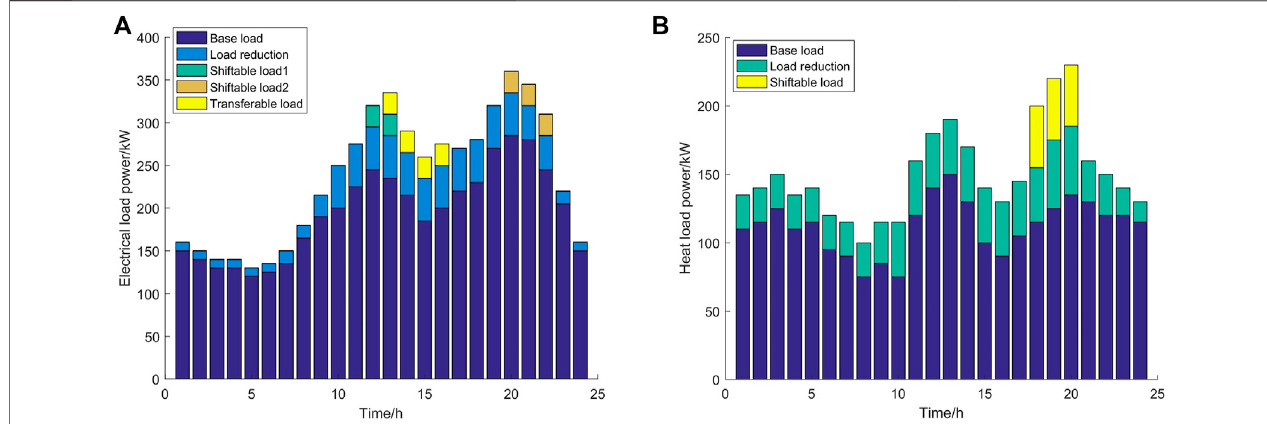
FIGURE 5 | User-side electric and heating load distribution before optimization. (A) Electrical load and (B) heat load